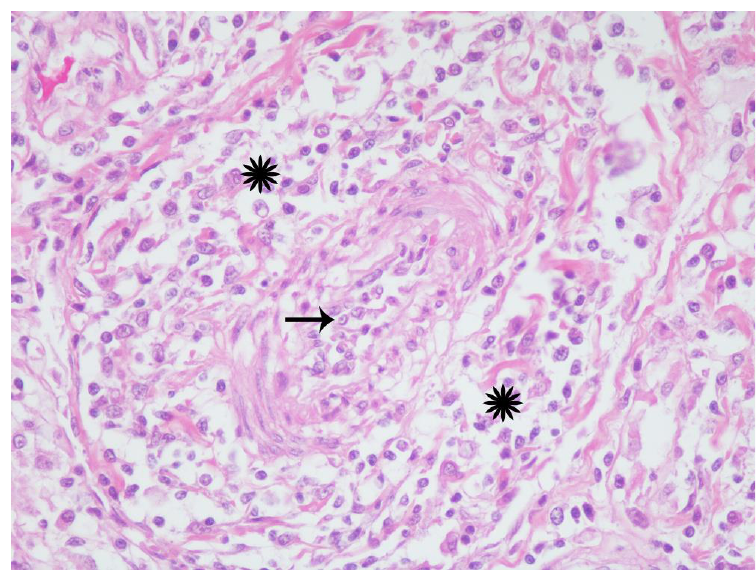
Figure 4. California sea lion, mesenteric arteriole. A medium caliber arteriole has circumferential mural thickening (starbursts) and luminal attenuation (arrow) with infiltration and separation of collagen fibers and smooth myocytes by similar inflammatory cells. Hematoxylin and eosin, 40× magnification.